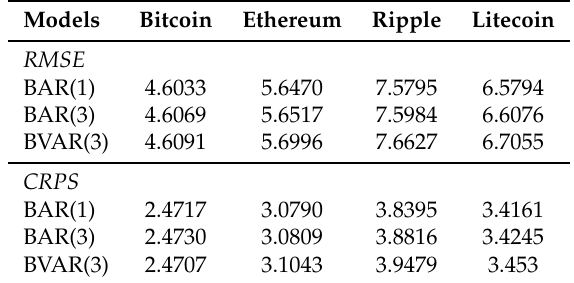
Table 7. Point (RMSE) and Density forecasting (CRPS) for Bayesian AR(1), AR(3) and